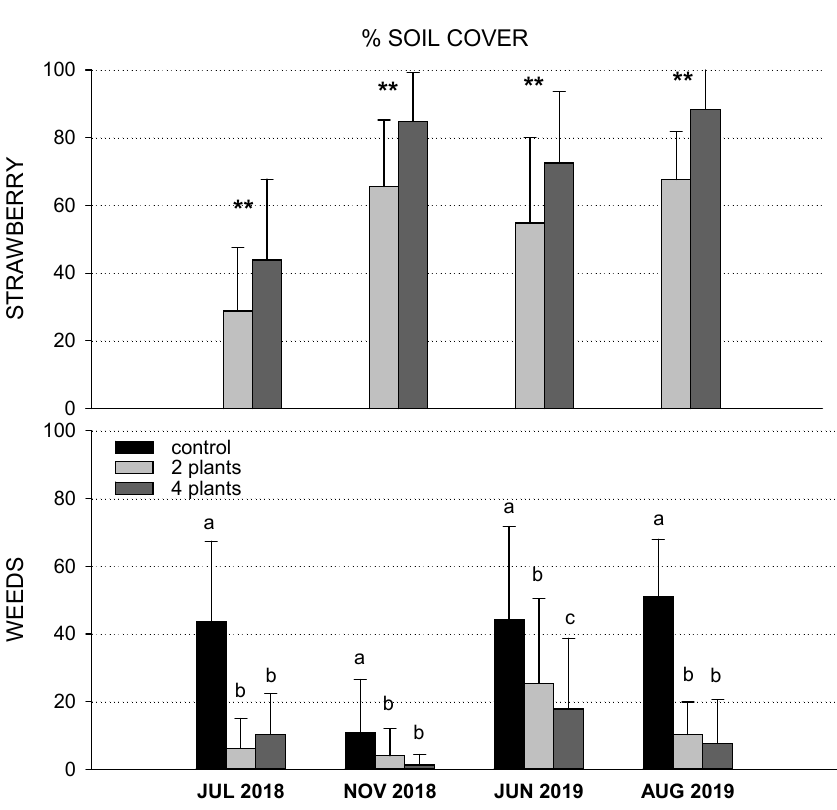
Figure 3. Percentage (%) of soil covered by strawberry plants ( top ) and weeds ( bottom ) (mean ± SD). Asterisks (**) and different letters indicate statistically significant difference (Tukey’s HSD test).